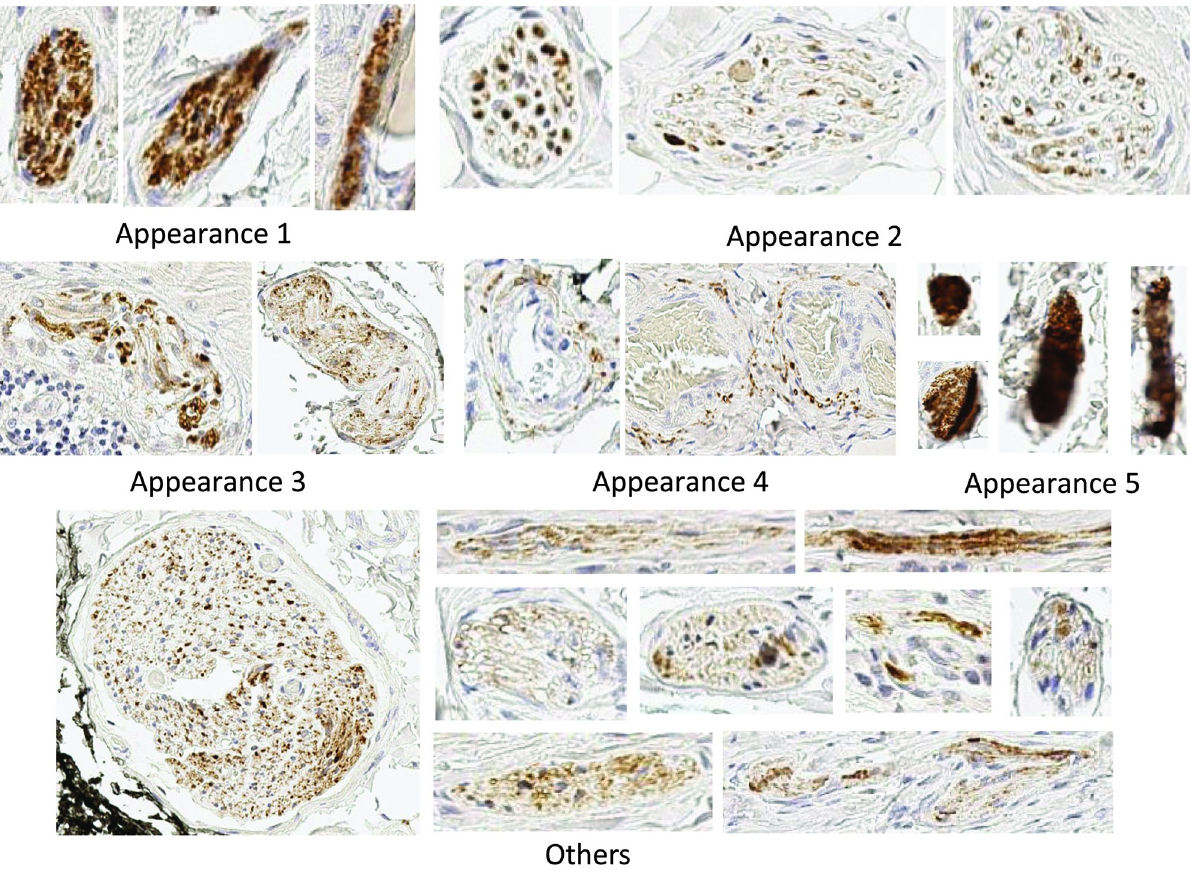
Fig 2. Examples of variation in the appearance of nerves.